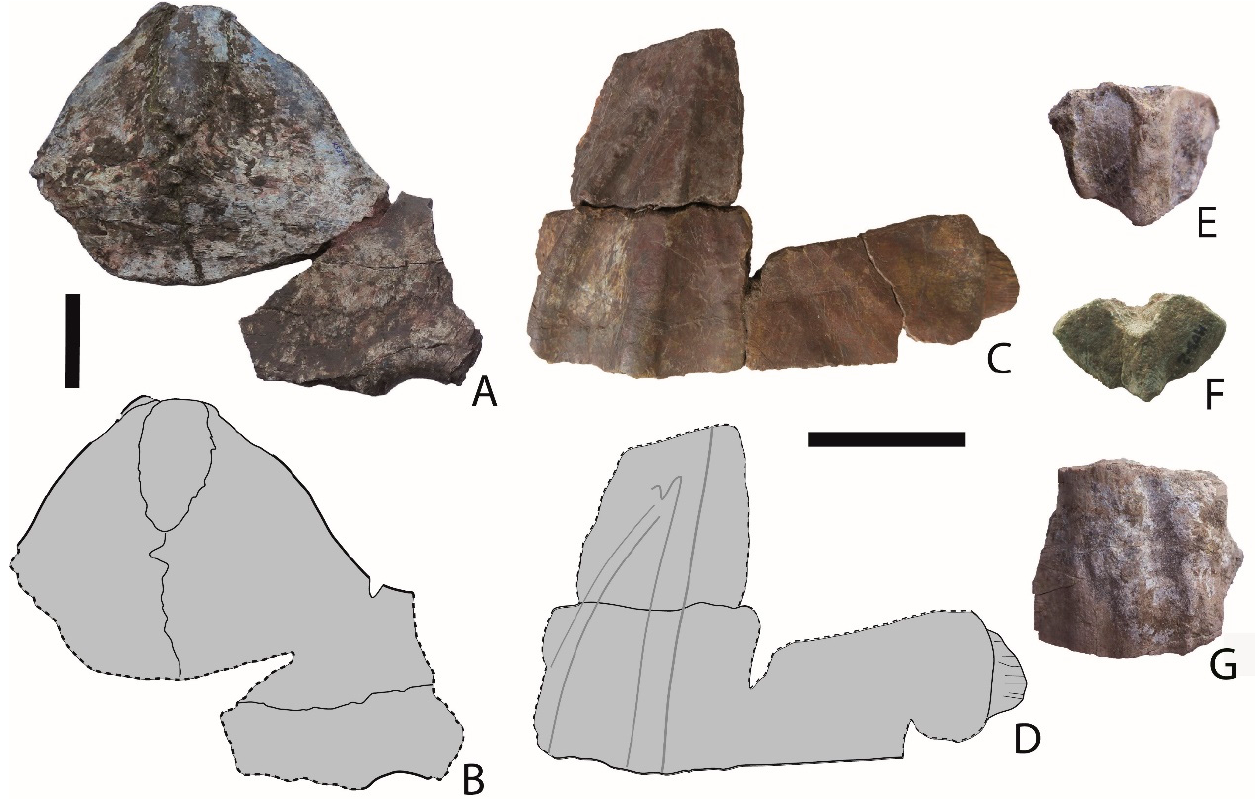
Figure 3. Yakemys multiporcata n. g. n. sp. from the upper part of the Phu Kradung Formation (basal Cretaceous) of Khorat Plateau, NE Thailand. ( A , B ): Holotype (SM KS39) from Ban Hui Yang locality, Sam Chai District, Kalasin Province, partial plastron in dorsal view; ( C , D ): two incomplete costals (PRC151) from Phu Phan Kham locality, Nong Bua Lamphu Province; ( E ) (PRC152), a posterior neural, ( F ) (SM2021-1-131), a suprapygal 1 and ( G ) (PRC153), a fragment of costal from Dan Luang locality, Mukdahan Province. Scale bar = 5 cm (vertical scale for ( A , B ); horizontal scale for ( C – G )).